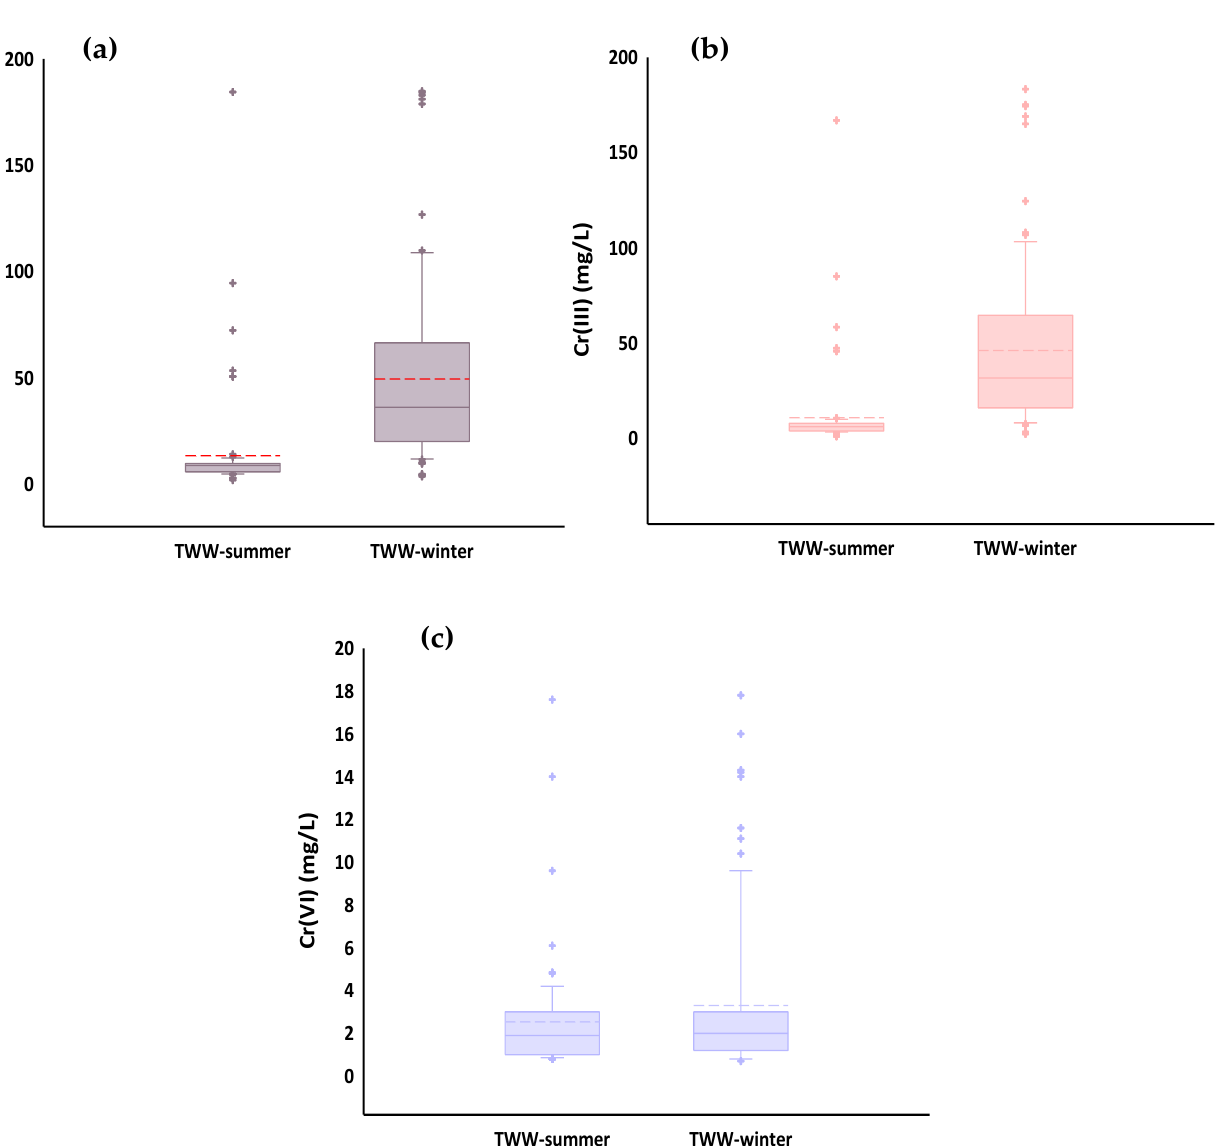
Figure 1. Box plot showing the quartiles and mean of the measured ( a ) chromium (total Cr), ( b ) trivalent Cr ((Cr(III)) and ( c ) hexavalent Cr ((Cr(VI)) values from the tannery industry wastewater samples collected from various tannery industries sites in summer and winter seasons from Punjab, Pakistan. Tannery wastewater samples, which were taken from the main channels receiving wastewater from all the tanneries, showed the highest Cr concentration in both TWW- winter and TWW-summer samples (up to 72 and 44 mg L − 1 , respectively). Among all the tanneries, tannery 2 had the highest Cr concentration (39 mg L − 1 ) in TWW-summer and tannery 20 had the maximum Cr concentration (125 mg L − 1 ) in the TWW-winter samples. The tannery 1 and tannery 13 samples showed the lowest Cr concentrations (2.8 and 4.0 mg L − 1 ) in summer and winter seasons, respectively (Table